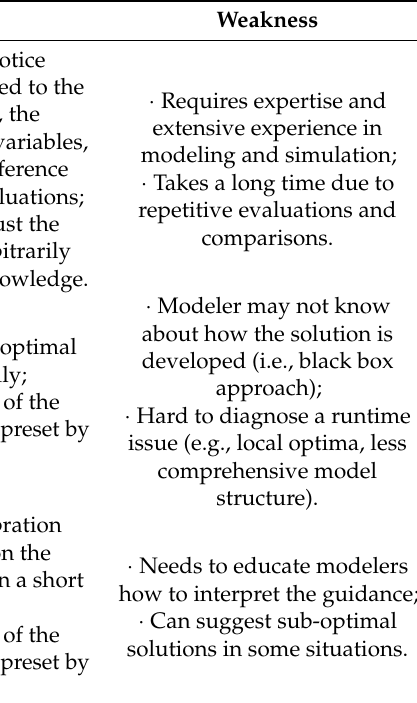
Table 6. Featured strengths and weaknesses of the calibration